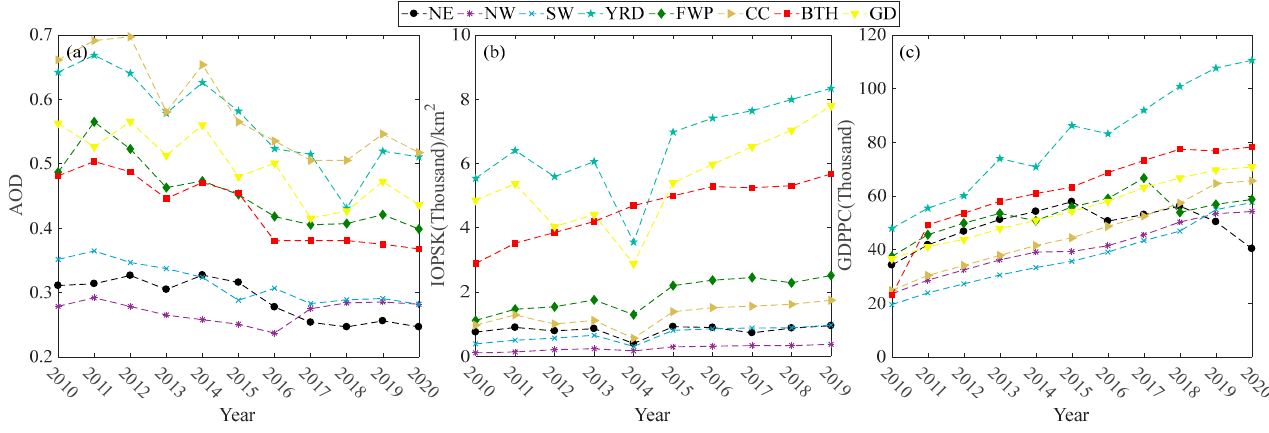
Figure 10. Temporal changes in the annual values of ( a ) AOD, ( b ) IOPSK, and ( c ) GDPPC in eight major areas from 2010 to 2020.